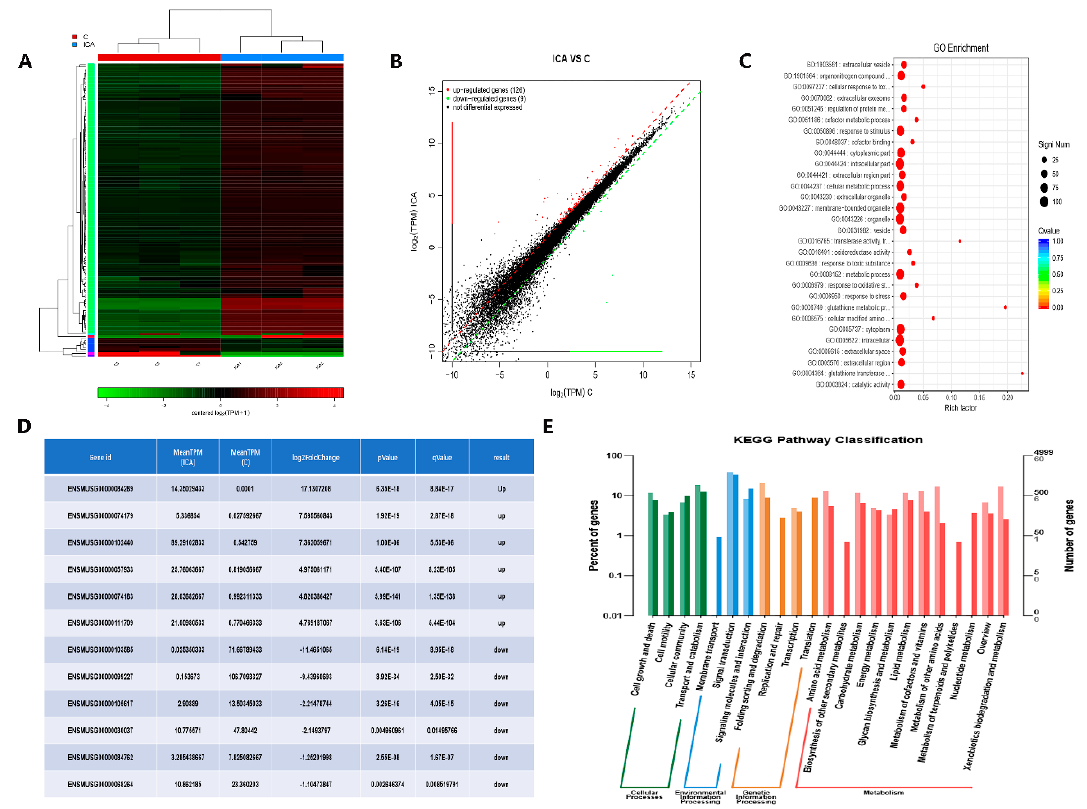
Figure 4. The gene expression profile of ICA-induced osteoblast di ff erentiation was analyzed with RNA-seq technology. ( A ) Heatmap of the di ff erentially expressed genes based on fold changes in the ICA and control group. Red indicates higher expression, and green indicates lower expression. ( B ) Di ff erential expression scatter plot of the comparison groups. A total of 135 genes were di ff erentially expressed after the addition of ICA; 126 were upregulated genes and 9 were downregulated genes. Black represents genes that were not di ff erentially expressed. ( C ) Significant enrichment functional scatter plot. The size of q-value is represented by the color of the dots. The smaller the q-value is, the closer the color is to the red color, and the number of di ff erential genes contained in each function is represented by the size of the dots. ( D ) The 6 most significantly upregulated and downregulated genes. Genes listed from top to bottom according to the significance of the DEGs. ( E ) KEGG pathway classification shows the relationship between metabolic pathways and di ff erentially expressed genes through a classification histogram. Di ff erent colors represent di ff erent classifications. Light colors represent di ff erentially expressed genes and dark colors represent all